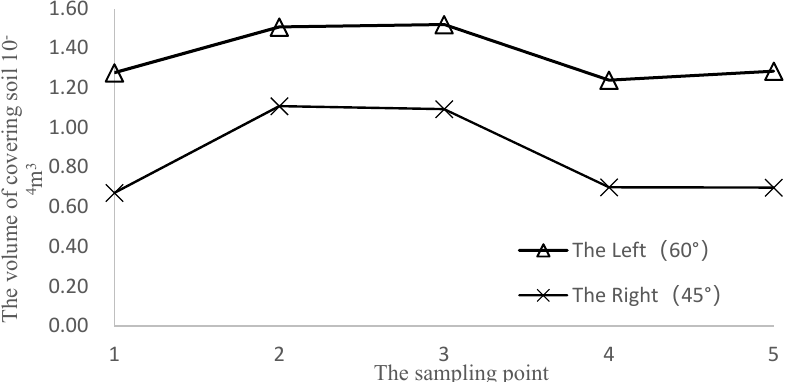
Figure 9. The volume of covered soil at different sampling points (Both the angles of left and right disc are 60 ◦ and 45 ◦ , respectively).